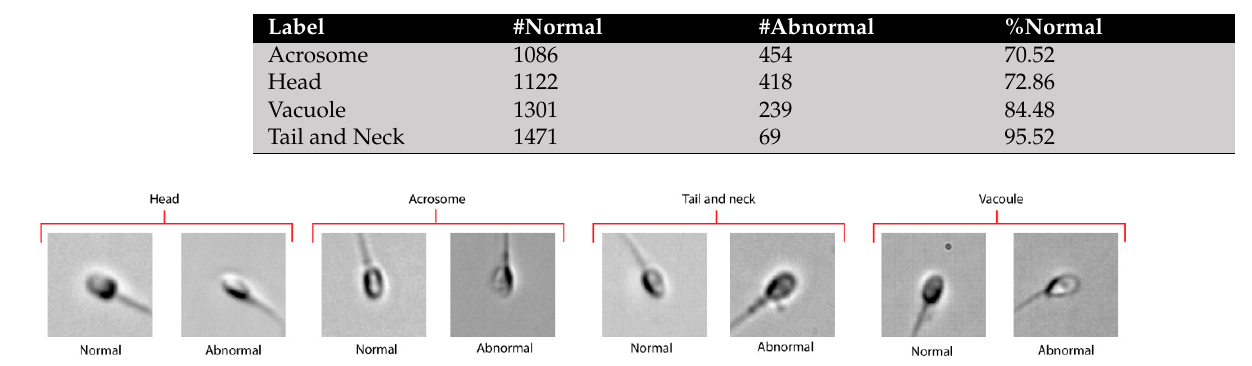
Table 2. MHSMA dataset samples details.